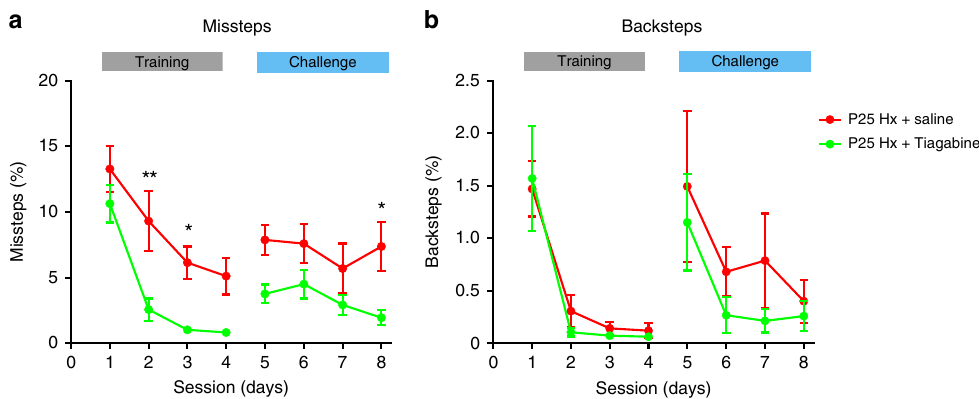
Fig. 7 Pharmacological intervention using a GABA reuptake inhibitor ameliorates locomotor malperformance in Hx mice. a Comparison of misstep percentages between Tiagabine-treated Hx animals (green trace, P25 Hx + Tiagabine, n = 6 animals) and controls (red trace, P25 Hx + saline, n = 5 animals). Statistics: two-way ANOVA, intervention effect F (1,72) = 46.91, P < 0.0001, session effect F (7,72) = 9.957, P < 0.0001, intervention × session F (7,72) = 0.6637, P = 0.7018). b Comparison of backstep percentages between Tiagabine-treated (green trace) and controls (red trace). Statistics: two-way ANOVA, intervention effect F (1,72) = 2.064, P = 0.1551, session effect F (7,72) = 6.903, P < 0.0001, intervention × session F (7,72) = 0.2729, P = 0.9625). Error bars denote SEM. Note difference in y scale between panels. Asterisks represent results of Sidak ’ s multiple comparison test following two-way ANOVA. ** P < 0.01, * P <